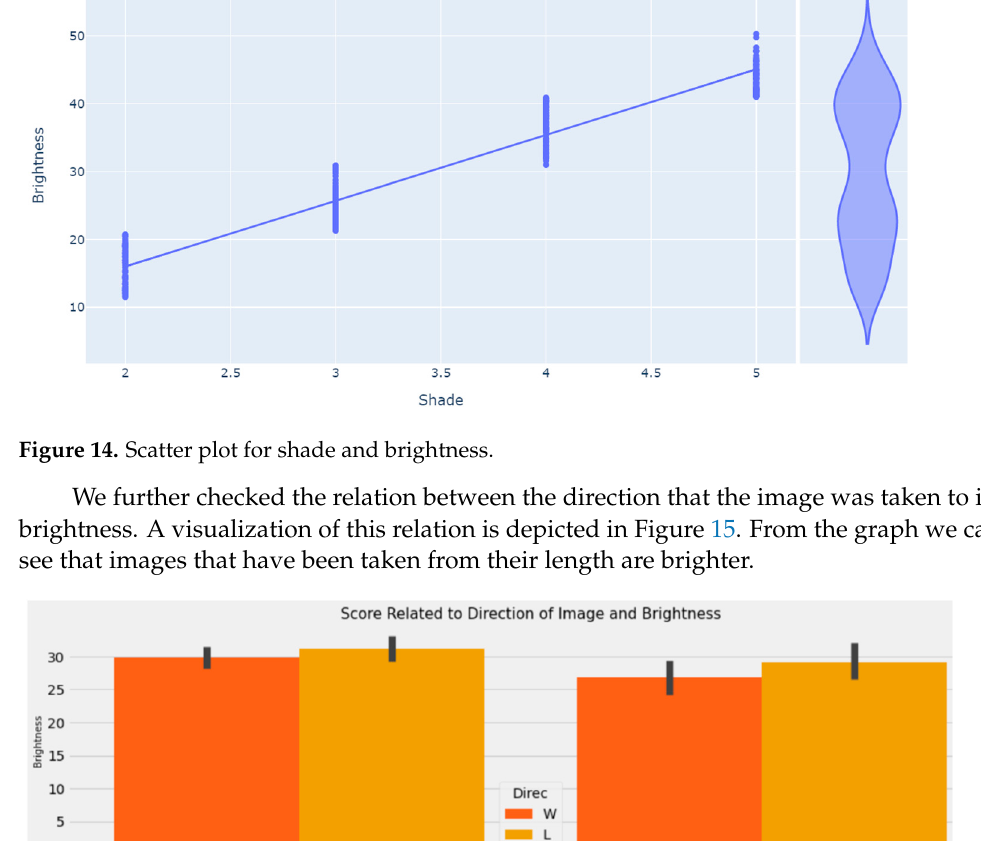
Figure 16. An example of the processed dataset after one-hot encoding the column color. Label-Encoder—Label-Encoder is a method to encode a categorical class between 0 and N-1 Classes, where N is the number of labels in a class [1]. We used label-encoding for the Direction class. The two labels: L and W are encoded to 0 and 1, respectively. 4.2.4. Imbalanced Data (Resampling) As we have seen, our dataset, and in particular the target column, is imbalanced. To balance the dataset, we have applied the resampling method by adding records to the minority class or deleting records from the majority class [27,32]. Oversampling and un- der-sampling are opposite and roughly equivalent techniques. To avoid data loss, we have used oversampling. We used a SMOTE oversampling technique. The algorithm is as fol- lows: for each pattern in 𝑋 (cid:2868) from the minority class: (1) Pick one of its K nearest neighbors X (belonging to the minority class also); (2) Create a new pattern Z on a random point on the line segment connecting the pattern and the selected neighbor as follows: 𝑧 = 𝑥 (cid:2868) (cid:3397) 𝑤(cid:4666)𝑥 − 𝑥 (cid:2868) (cid:4667)